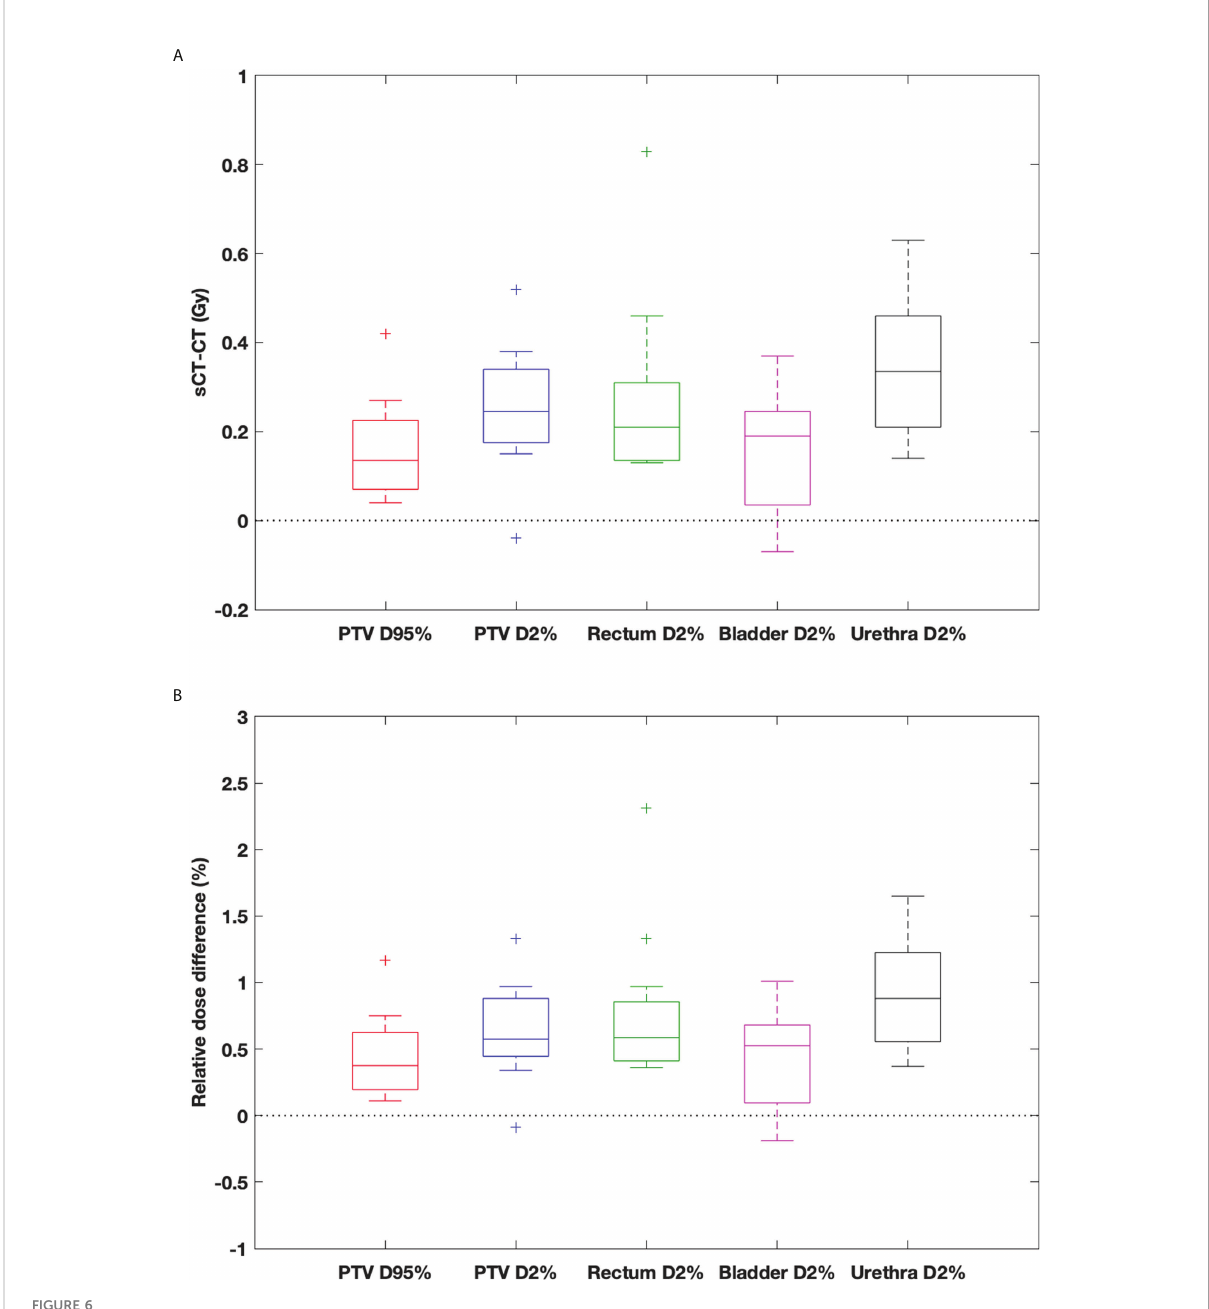
FIGURE 6 Box-and-whisker plots of (A) dose difference (Gy) and (B) relative dose difference (%) between sCT ave and dCT corr for PTV and OAR metrics. The bottom and top of the box represent the 1st and 3rd quartiles; the band inside the box is the median; the ends of the whiskers represent 95% range; the crosses represent